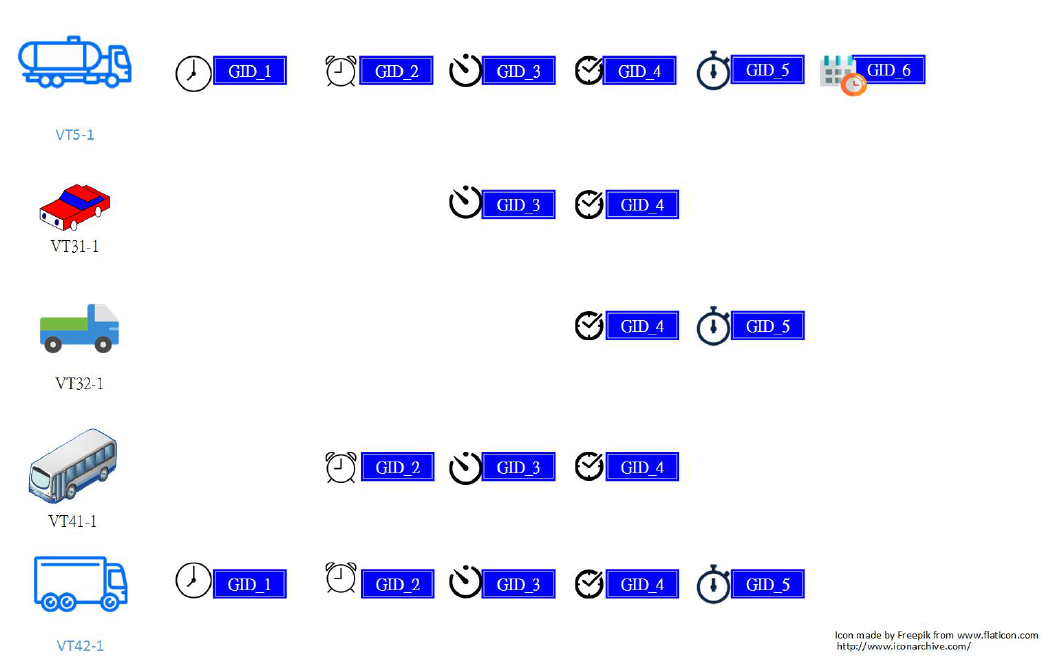
Figure 2. Example: the gantry timestamp sequences of five vehicles according to the trips in Figure 1; “Reproduced with permission from 2017 International Conference on Applied System Innovation (ICASI); published by IEEE, 2017.”